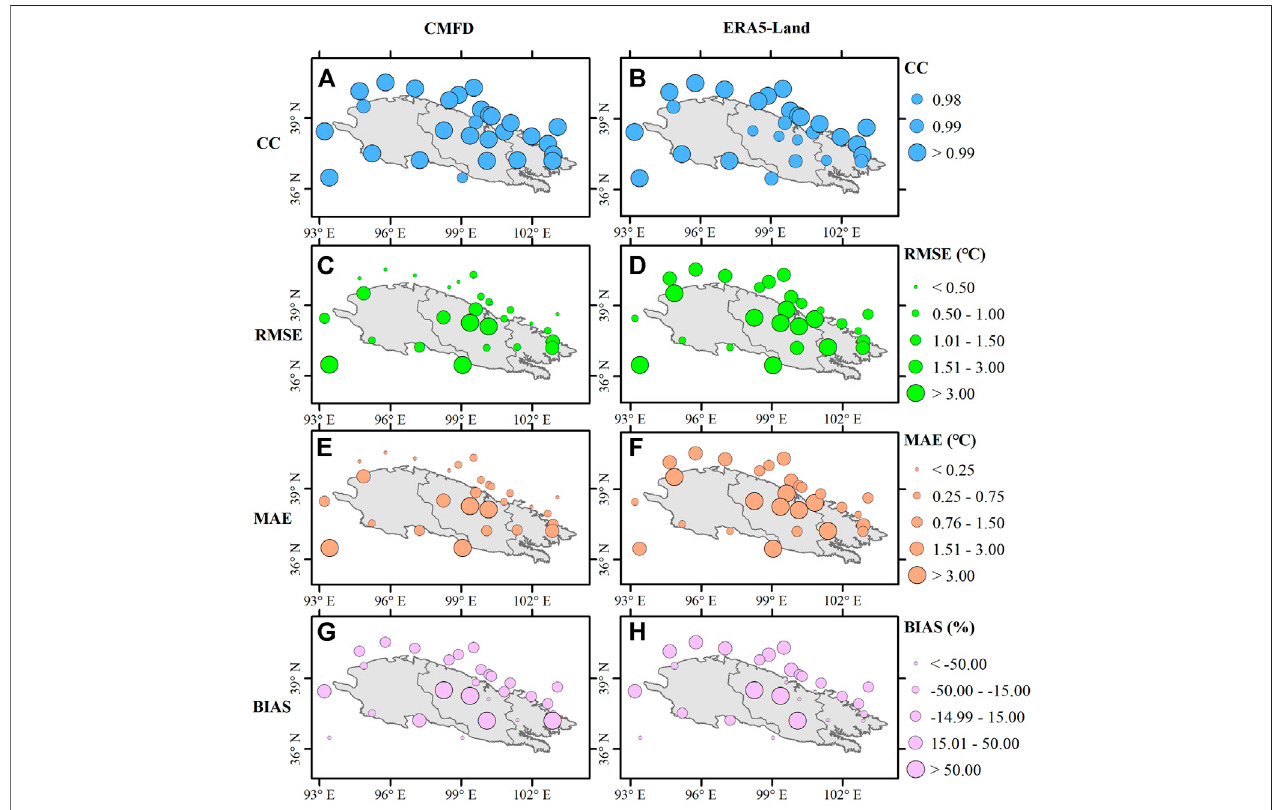
FIGURE 8 | Correlation coef fi cients (CC) (A,B) , root mean square error (RMSE) (C,D) , mean absolute error (MAE) (E,F) , and mean bias (BIAS) (G,H) of monthly temperature in the two reanalysis datasets, relative to monthly mean temperature observations.